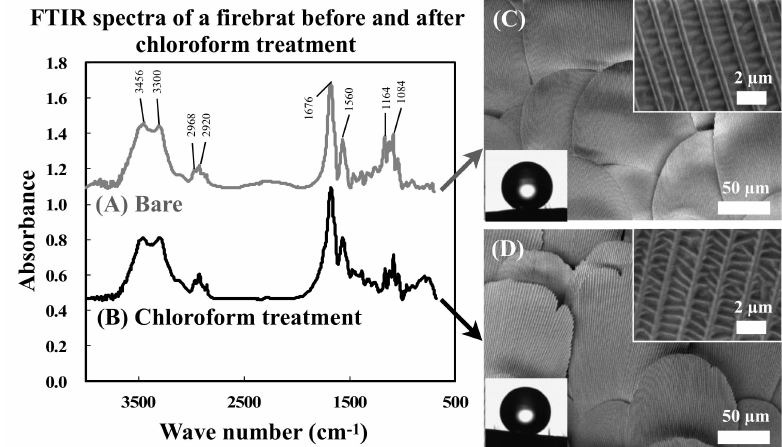
Figure 3. Surface analysis of firebrat scale surface before and after chloroform treatment. ( A , B ) FTIR spectra and ( C , D ) FE-SEM images and photographs of water droplets on the firebrat dorsal surface. ( A , C ) Bare surface and ( B , D ) chloroform-treated surface. Table 1. Assignments of the relevant bands of FTIR spectra of the firebrat surfaces before and after CHCl 3 treatment. Wave Number (cm − 1 ) Assignments Before Chloroform Treatment After Chloroform